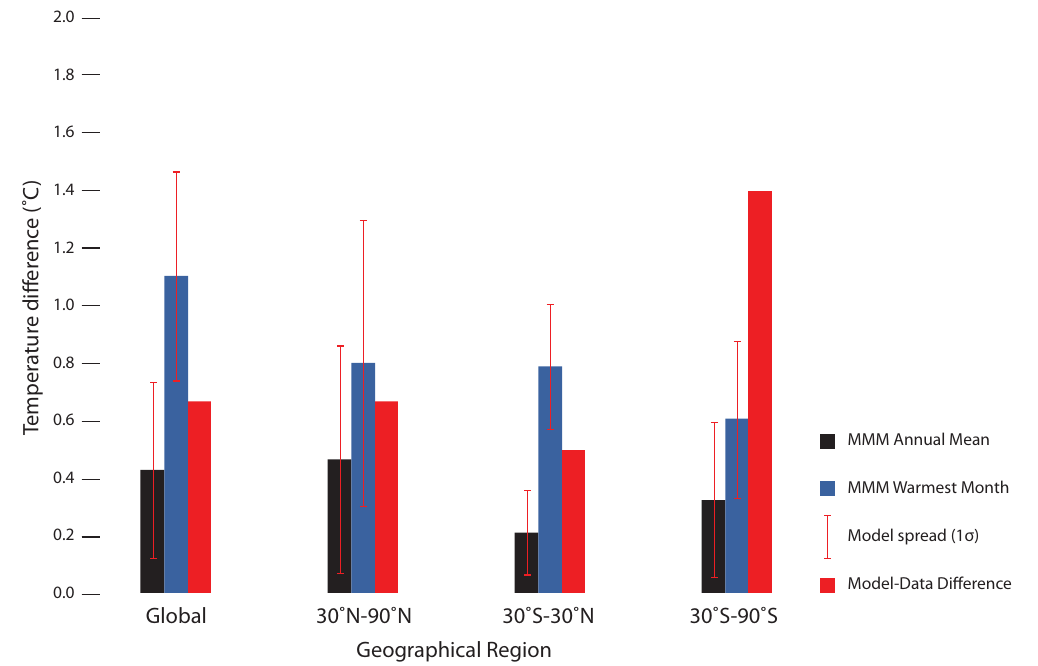
Figure 6. Comparison of calculated overestimation of the LIG thermal maximum and reported LIG model–data mismatch. The calculated MMM overestimation of annual mean (black) and warmest month temperatures (blue; ◦ C) during the LIG thermal maximum, including inter-model spread (1 σ ; red) compared with the model–data mismatch (red) reported by Otto-Bliesner et al. (2013). The calculated MMM overestimation is illustrated by the differences between the compilation-warmest-periods and the warmest-single-period methods. Values are given for four different geographical regions. The model–data mismatch is based on a combination of terrestrial and oceanic data, comparison at proxy locations only and on a CCSM3 simulation forced with 130ka forcings (see for details Otto-Bliesner et al.,